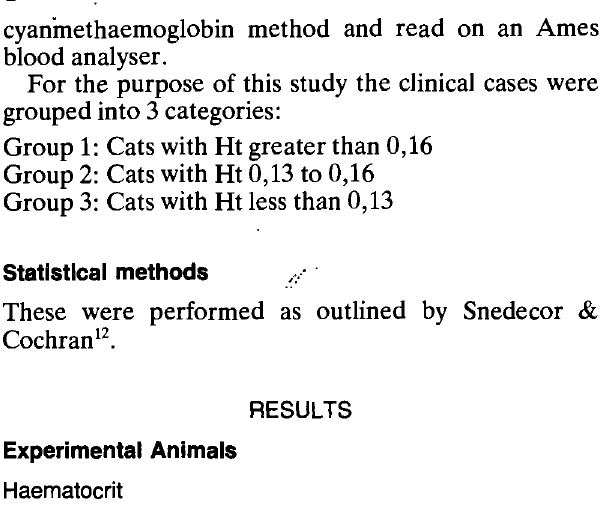
(b) Non-splenectomised cats (Table 5)